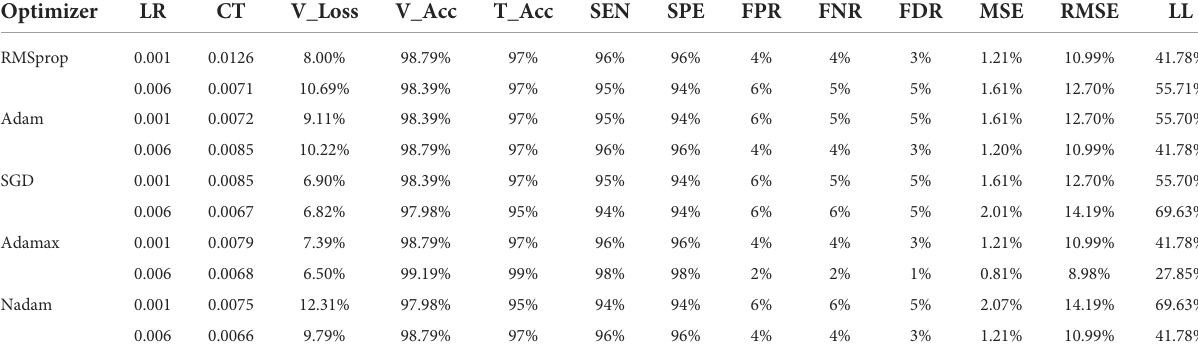
TABLE 7 A detailed comparison of testing accuracies among all the optimizers with different learning rates, comparison of the optimizers and optimistic outcomes of various optimizers on the ISIC malignant dataset . Optimizer LR CT V_Loss V_Acc T_Acc SEN